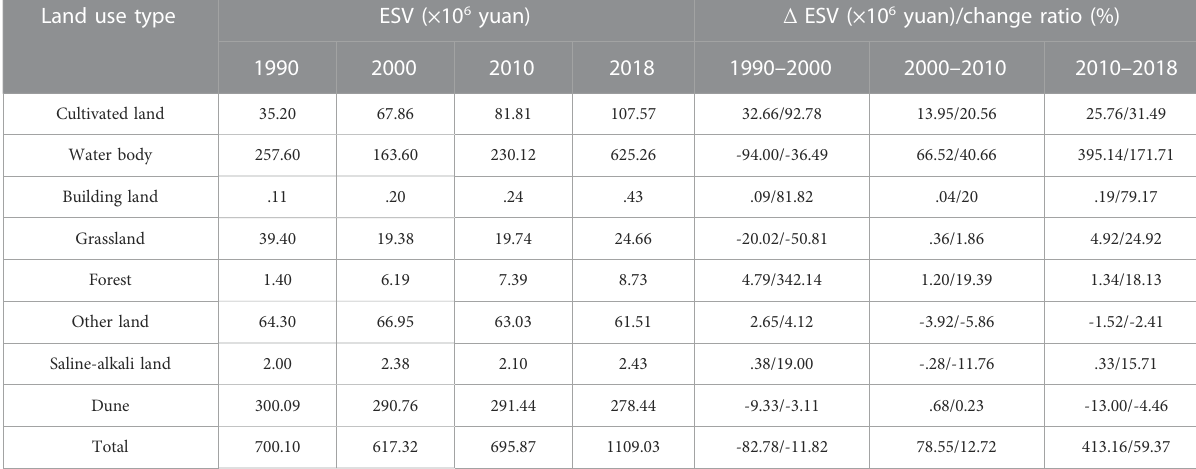
TABLE 3 ESVs of different land-use types in the Ulan Buh Desert from 1990 – 2018. Land use